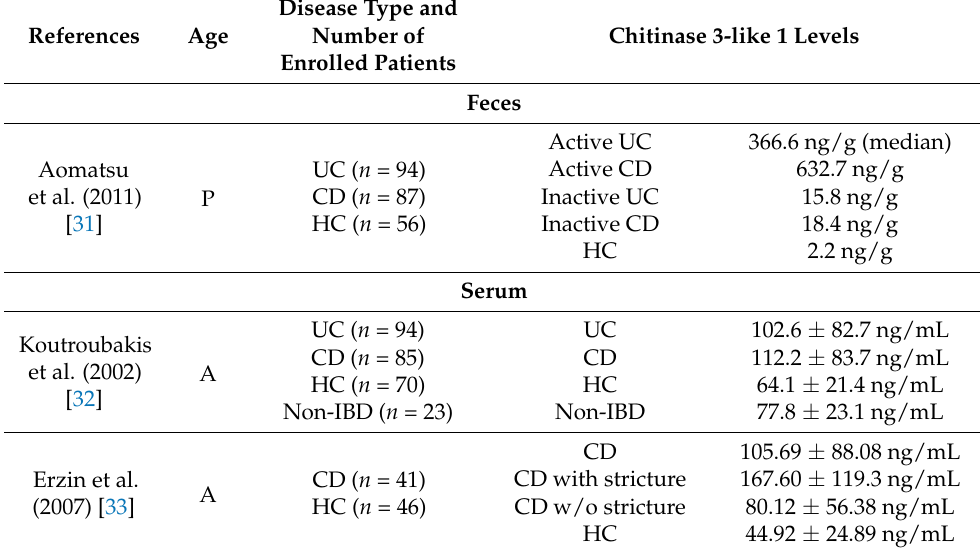
Table 1. Use of fecal and serum CHI3L1 as a biomarker and its association with inflammatory bowel